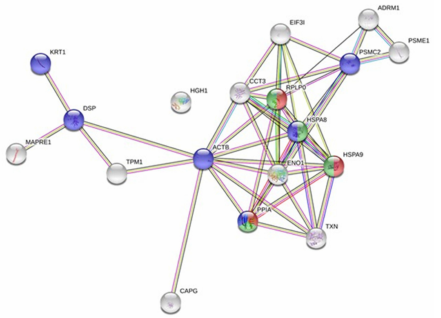
Figure 4. Bystander whole-cell proteome network. Protein–protein interaction network constructed with protein accession from the list of 20 modulated proteins (9 up-regulated and 11 down-regulated) in the bystander proteomic analysis. The network was constructed on STRING